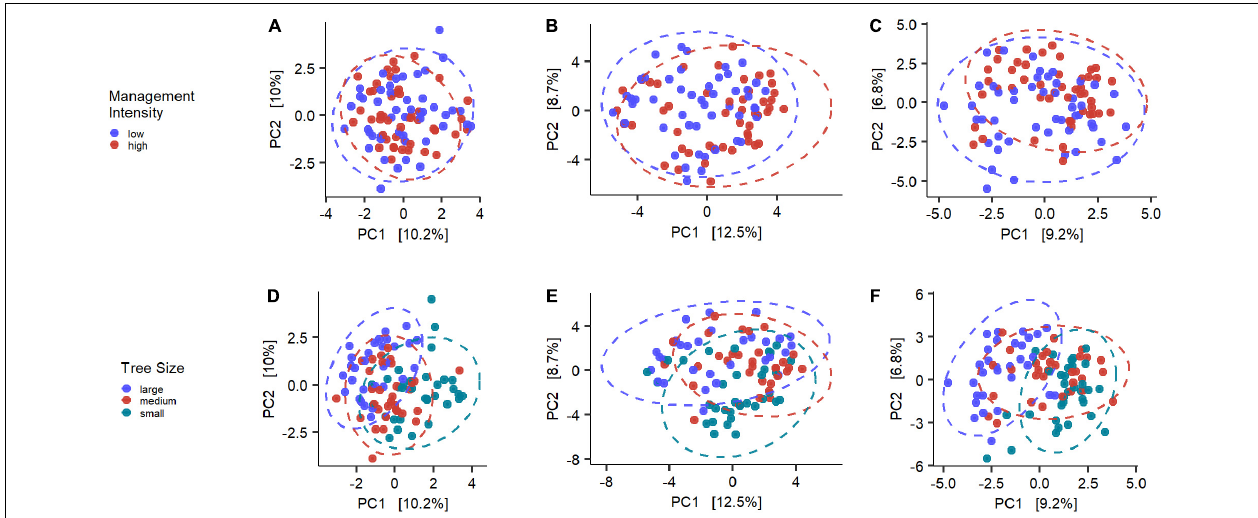
FIGURE 5 | Overview of the Principle Component Analysis for algae (A,D) , bacteria (B,E) and fungi (C,F) . Colors indicate the tested groups and axes are scaled to the proportion of variance explained by the displayed Principal Component (Nguyen and Holmes, 2019).